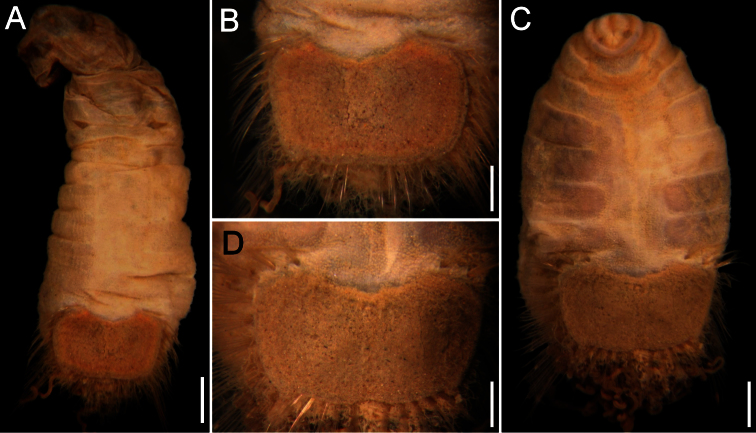
Caulleryaspis laevis (Caullery, 1944) comb. n. A Lectotype (ZMA 1535), ventral view B Same, ventro-caudal shield C Paralectotype (ZMA 5530), ventral view D Same, ventro-caudal shield. Bars: A 1 mm B 0.5 mm C 1.1 mm D 0.6 mm.